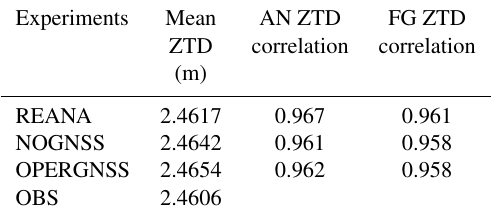
Table 3. Mean zenithal total delays (ZTDs) for REANA, NOGNSS and OPERGNSS analyses and Marfret Niolon observations (first column). Correlation of ZTDs between REANA, NOGNSS and OPERGNSS analyses and corresponding Marfret Niolon observa- tions (OBS) computed over the eight analysis slots and correlation between ZTDs forecasted by AROME-WMED at the 3h forecast range and corresponding observations from Marfret Niolon .